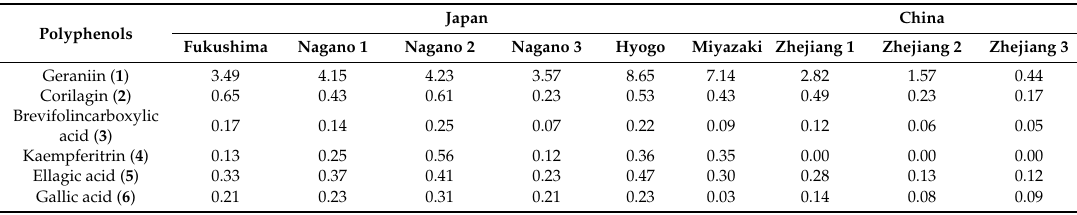
Table 3. The amounts of main polyphenols in G. thunbergii cultivated in Japan and China (mg/g dried weight).